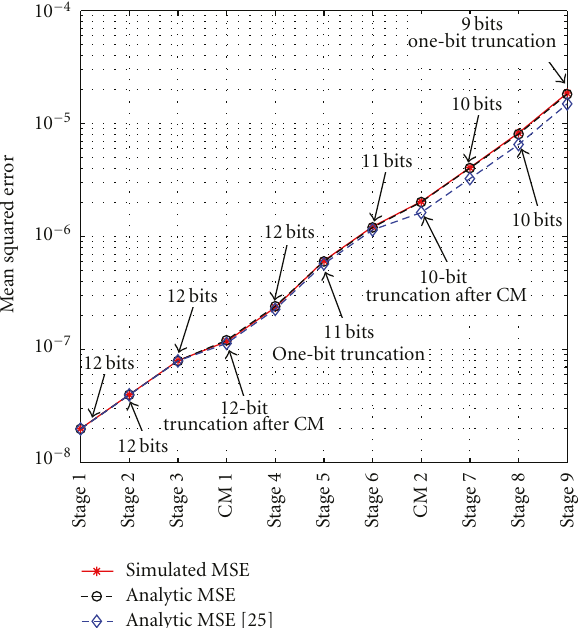
Figure 8: Comparison of analytic and simulated mean squared quantization errors at each stage in a 512-point FFT processor.